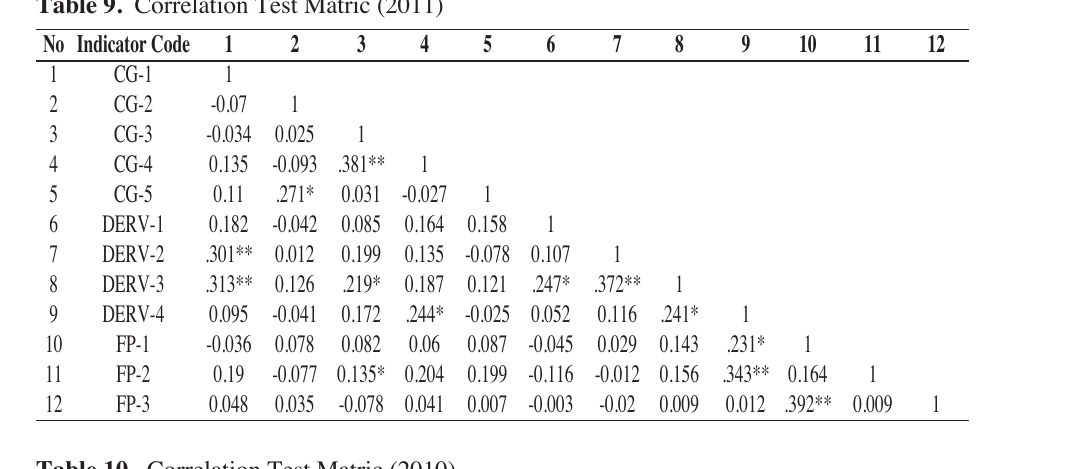
Table 10. Correlation Test Matric (2010)